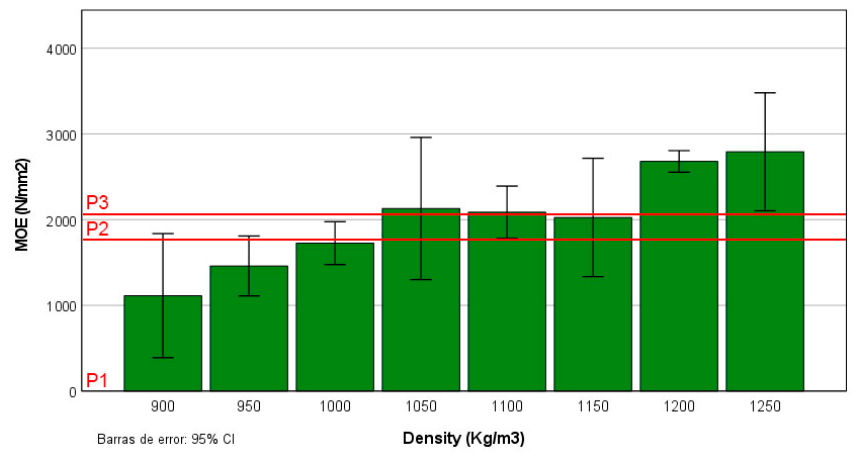
Figure 5. Modulus of elasticity (MOE) results of the experimental panels and the minimum require- ments of the European standards